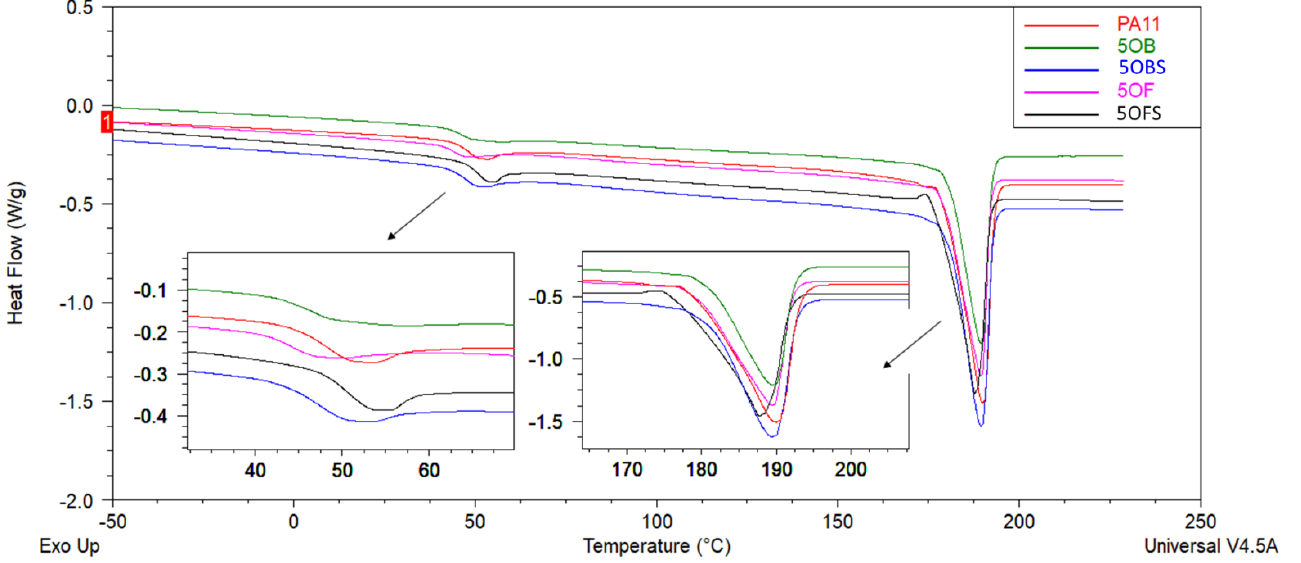
Figure 12. DSC curves of unmodified PA11 and composites, first heating; samples with 5% of diatoms.